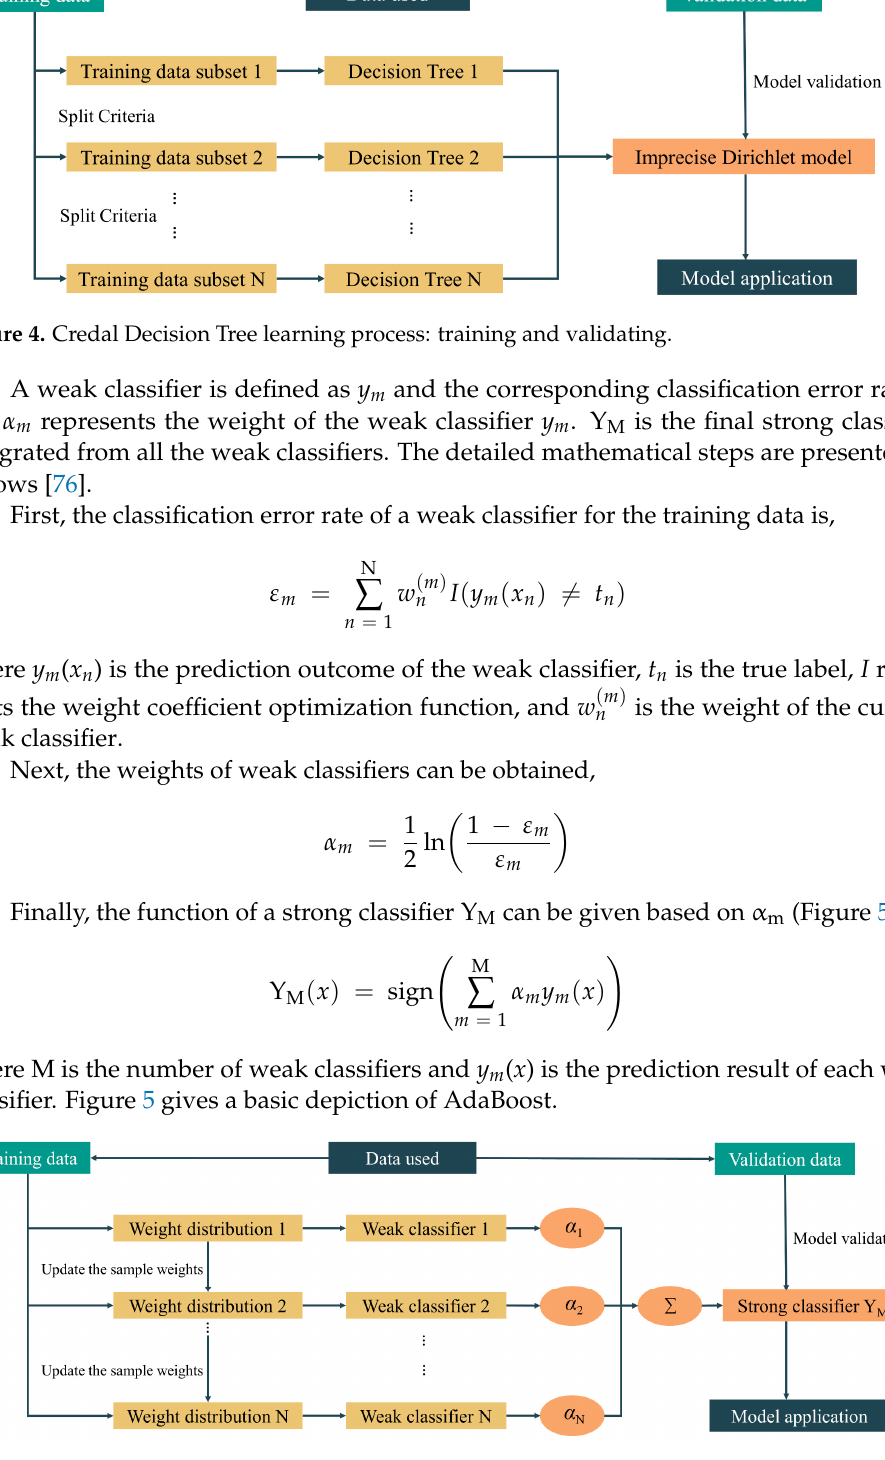
Figure 5. AdaBoost learning process: training and validating.